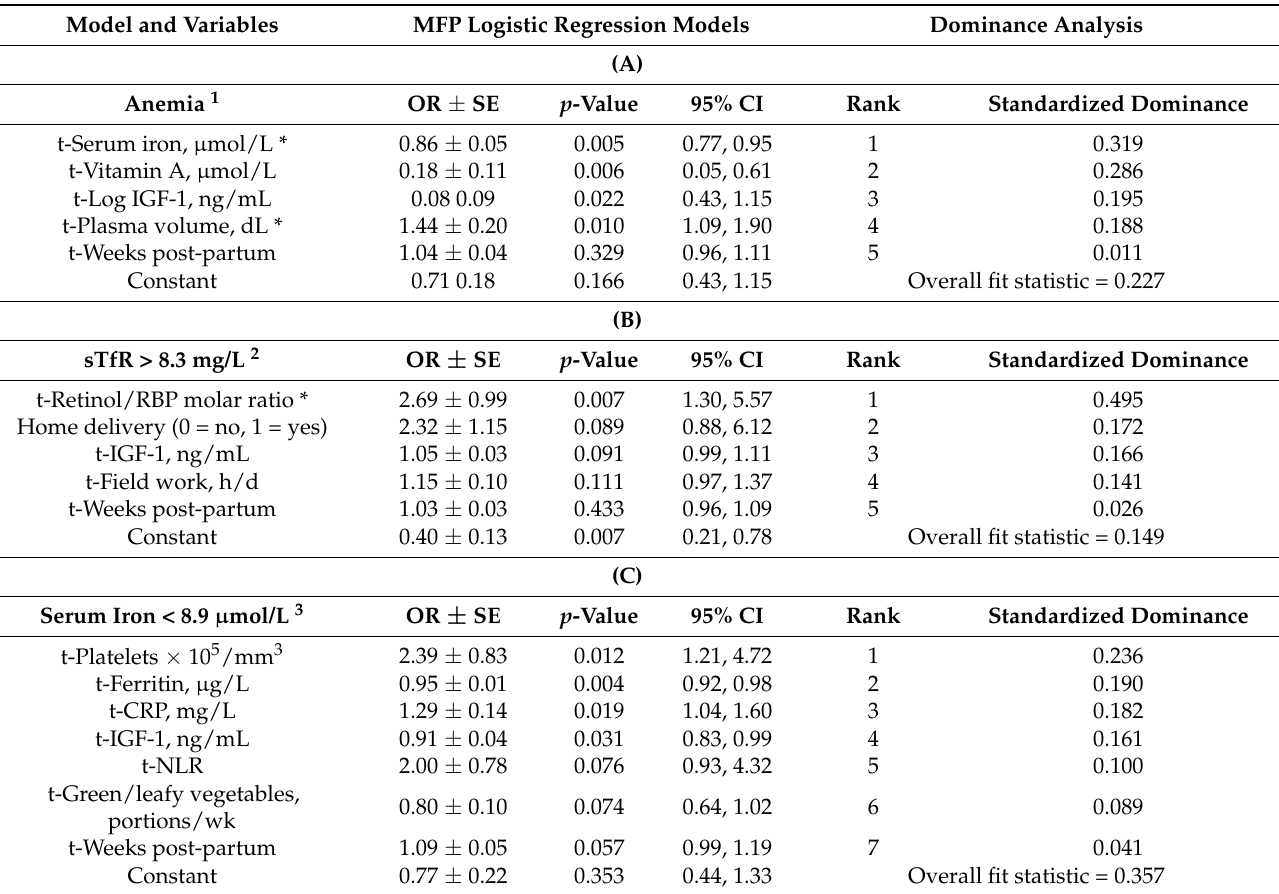
MFP logistic regression models for (A) anemia, (B) serum transferrin receptor (sTfR) > 8.3 mg/L, and (C) serum iron < 8.9 µ mol/L iron, with dominance analysis indicating